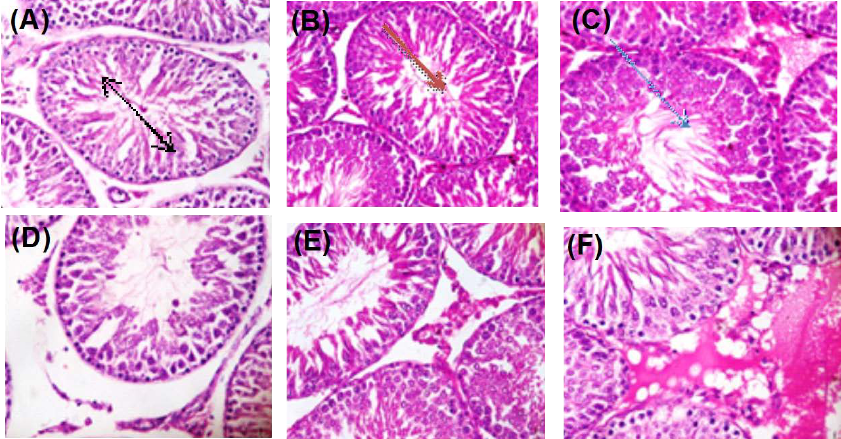
Figure 8: Photomicrograph of testes sections after exposure of rats to Ag-NPs showing; ( A ) several normal seminiferous tubules with normal spermatogonia cell, normal Sertoli cells, normal germ cell layer with normal maturation stages; ( B ) interstitial spaces show an area of interstitial congestion; ( C ) the lumen devoid of spermatozoa with interstitial congestion; ( D ) normal seminiferous tubules with normal spermatogonia cell, normal Sertoli cells, and normal germ cell layer; ( E ) maturation arrest of tubules and mild interstitial congestion; ( F ) seminiferous tubules with atrophy exhibiting thick double cell layers indicative of cessation of spermatogenesis. Magnification 400 × . A: Control, B: 10 mg / kg bw, C: 50 mg / kg bw, D: Control, E: 10 mg / kg bw, F: 50 mg / kg bw. A–C (7 days exposure of Ag-NP), D–F (28 days exposure of Ag-NP).